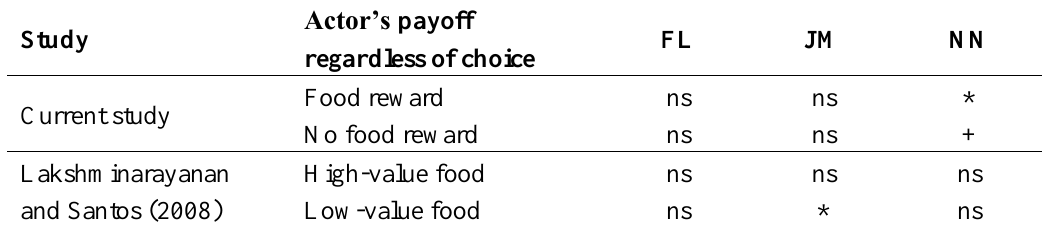
Table 1. Comparison of Actors’ Behavior across